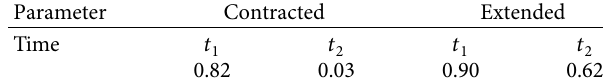
, θ ) and ( t , t ). 1 2 1 2 Table 2: Maximum contraction and extension times.